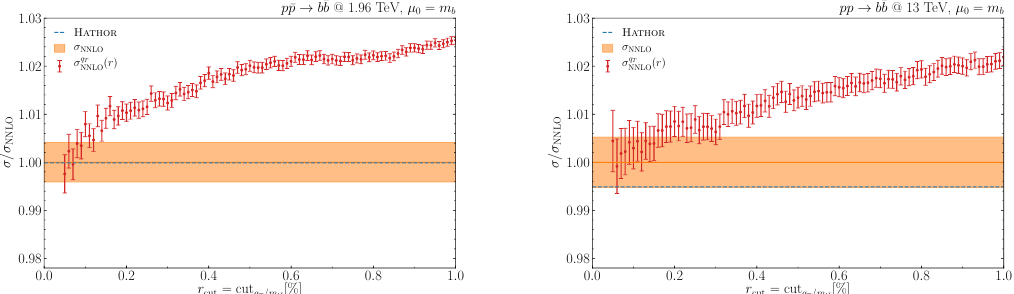
Figure 1 . The dependence on r cut of the total cross section for b (cid:22) b production at di(cid:11)erent hadron